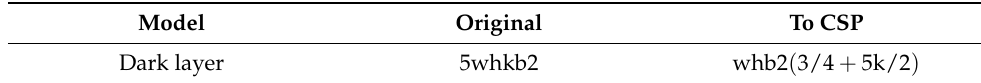
Table 1. Add CSP structured Dark Layer FLOPs.